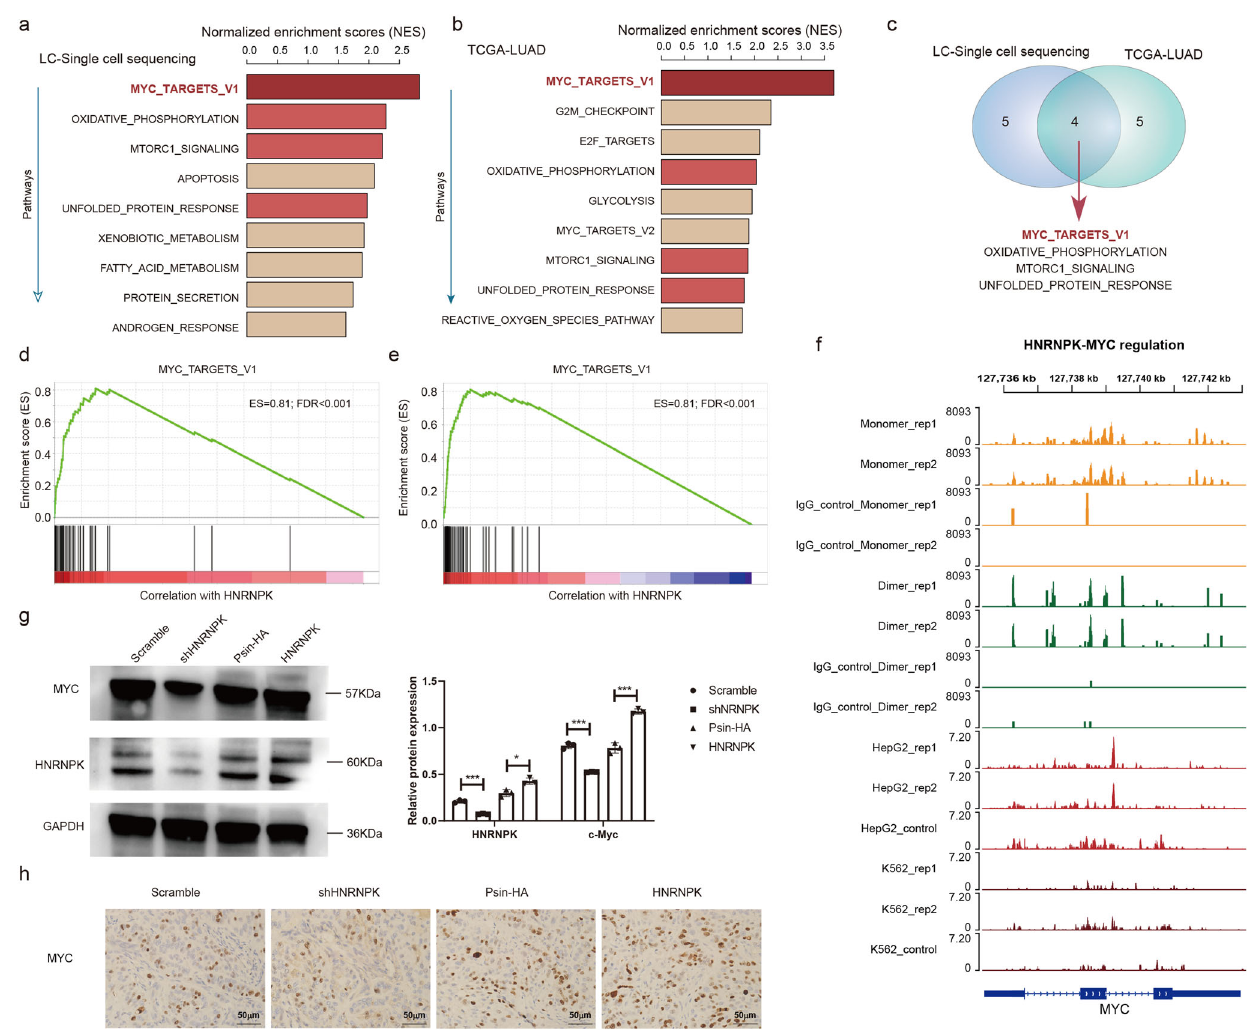
Fig. 6 HNRNPK-MYC signaling pathway perturbation in lung cancer. a , b Pathways enriched by potential targets of HNRNPK. a was based on single cell RNA-seq data and b was for TCGA bulk transcriptome analysis. c Venn plot showing the overlap of pathways in single-cell and bulk transcriptomes. d , e Enrichment plots of MYC target pathway identi fi ed by genes coexpressed with HNRNPK in lung cancer. d for single cell transcriptome analysis and e for bulk transcriptome analysis. f Genome visualization of HNRNPK binding with MYC in cell lines. g Relative protein expression of MYC in overexpression or knockdown of HNRNPK lung cancer cells. Error bars represent the standard errors. h IHC of MYC in overexpression or knockdown of HNRNPK lung cancer